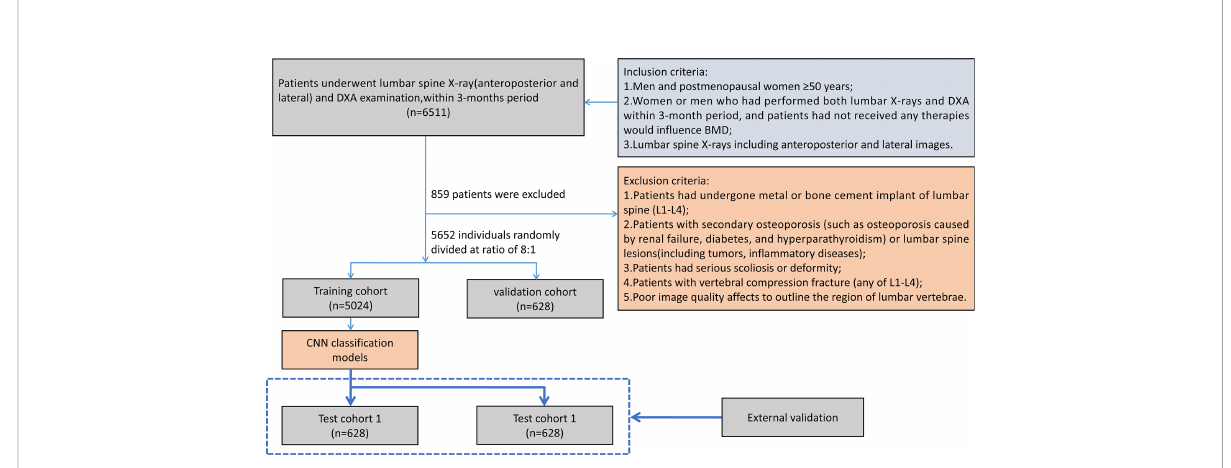
FIGURE 1 Flowchart of patient selection. BMD, bone mineral density; DXA, dual-energy x-ray absorptiometry; CNN, convolutional neural